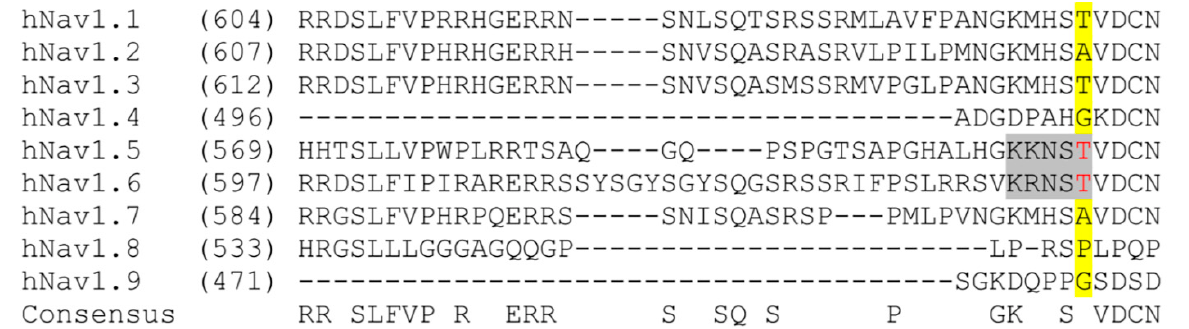
Figure 3. Nav1.6 protein sequence alignments of L1 region spanning amino acids 600–696 (human SCN8A ) compared to other Nav1.6 orthologs. T642 is denoted by the arrow. An * (asterisk) indicates a fully conserved amino acid residue. A: (colon) indicates conversation of amino acid residues with similar properties.